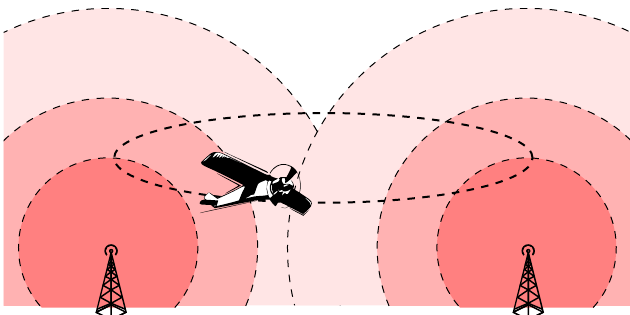
Figure 1: This figure illustrates how delay tolerant net- working can be used not only to extend the surveillance range, but also to increase the total data transmission rate. In the dark red areas the UAV can communicate with the base stations at a high transmission rate, whereas the transmission rate is poor in the light red areas. By bringing the UAV into range of the dark red areas, the total data transmission rate can be substantially in- creased even when taking into account the UAV’s flight time. To quote